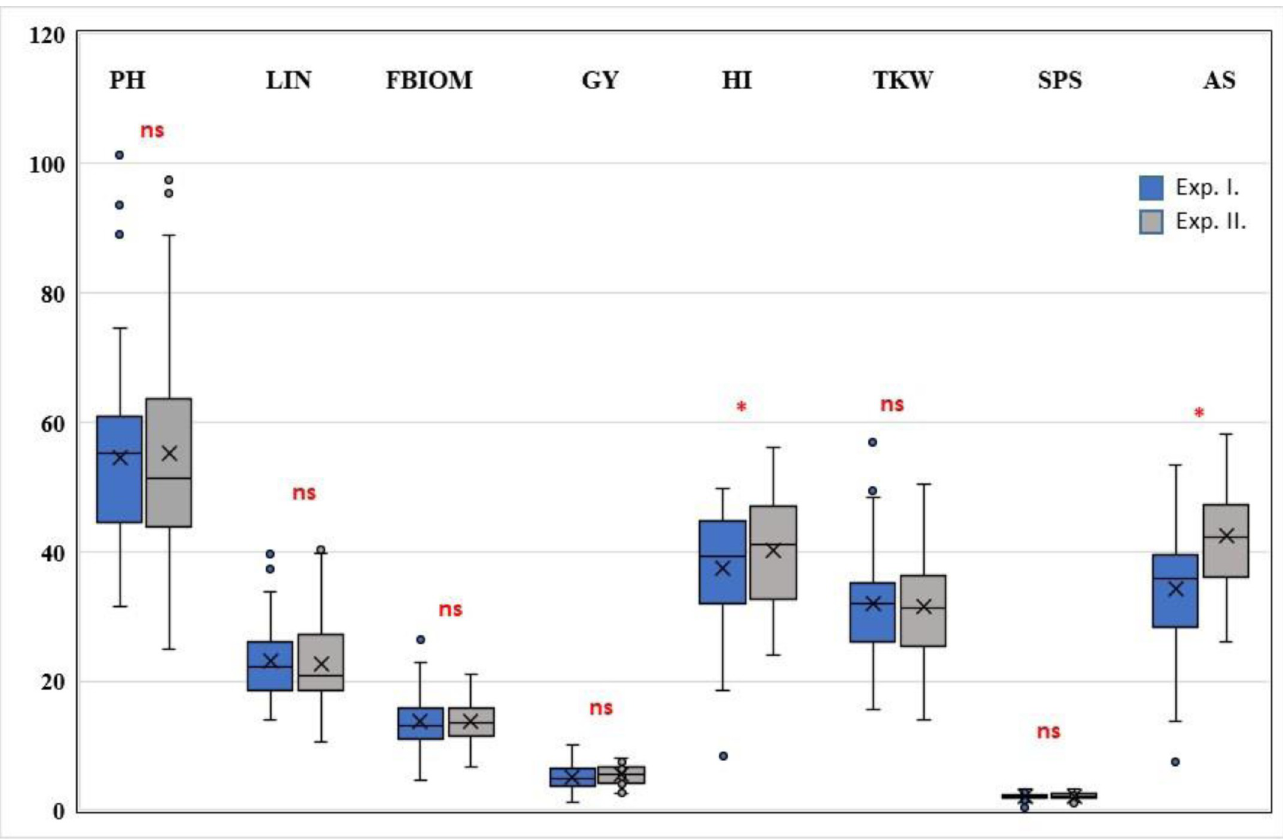
Fig 2. Comparison of various examined properties in the control treatments of the two heat stress experiments. PH—Plant height, LIN—Last internode length, FBIOM—Total aboveground biomass (straw + all ears), GY—Grain yield, HI—Harvest index, TKW—Thousand kernel weight, SPS—Grain number per spikelet, and AS—Average seed number; ns—not significant and � —significant at the P � 0.05 level.